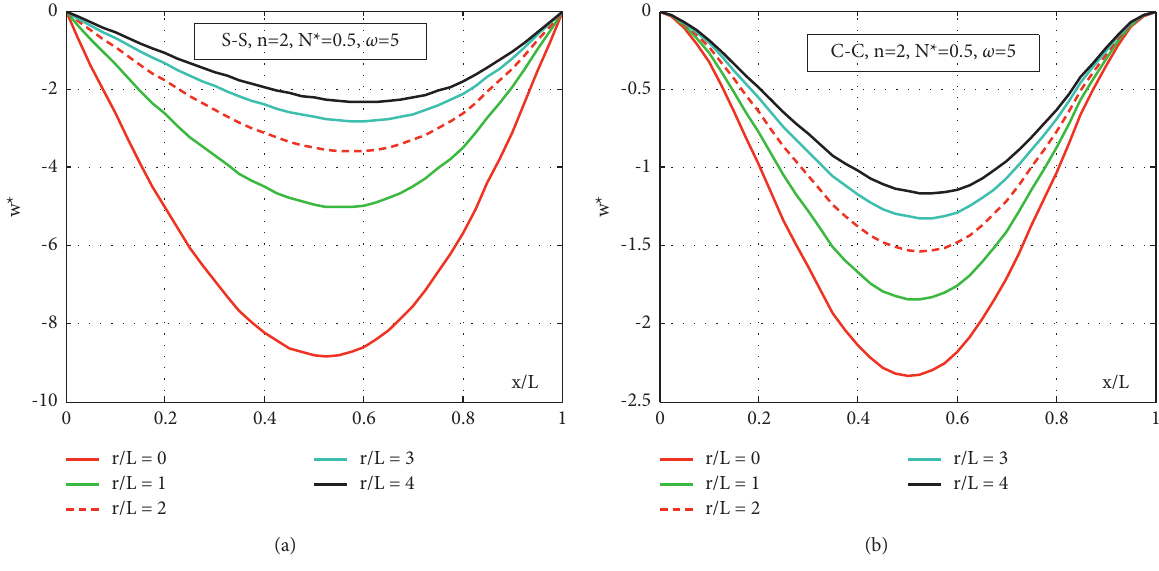
Figure 4: The deflection line of the FG beam on the (r)/(L) ration, K ∗